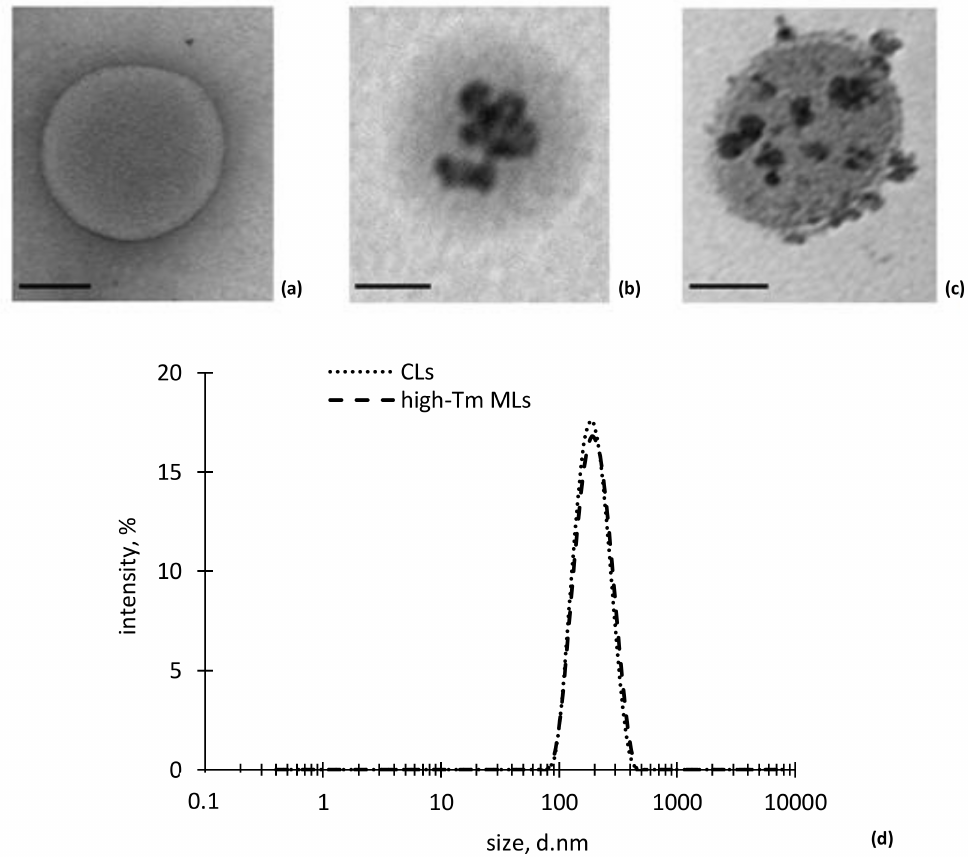
Figure 2. Transmission electron microscope (TEM) images showing hydrogenated soybean phosphatidylcholine (HSPC) liposomes ( a ) conventional and ( b , c ) high-Tm MLs. (scale bar: 100 nm); ( d ) DLS measurements of liposome